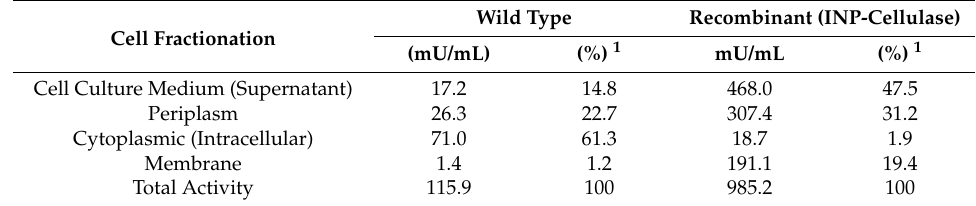
Table 1. Cell fractionation and location of cellulase activity in wild-type B. licheniformis and recombinant cell.